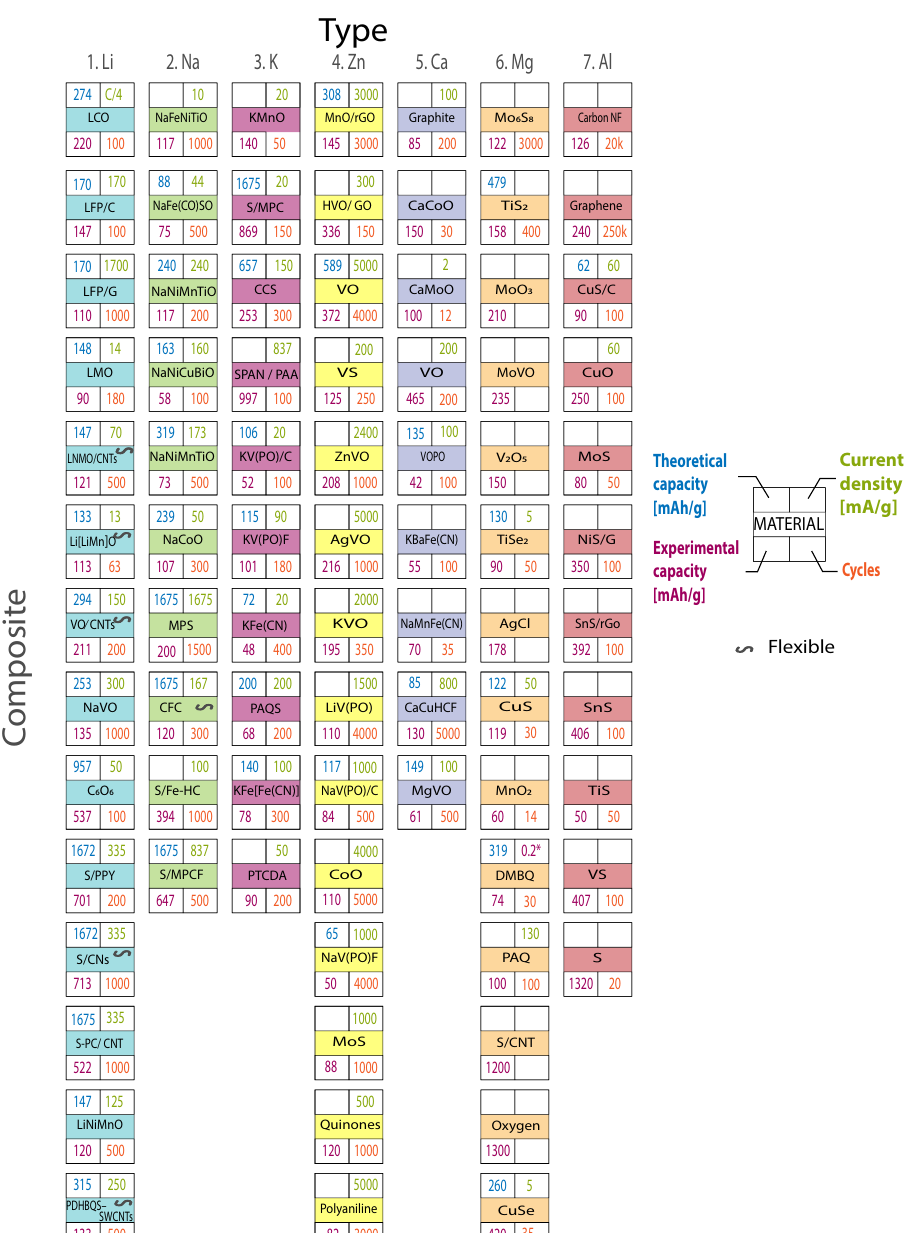
Figure 10. Current research in cathode materials. Columns organize the seven battery types. Rows represent the composite material group. Theoretical capacity, experimental capacity, current density, and the number of cycles are also included. A special symbol highlights flexible anode materials. Graph constructed by the authors from references in Tables